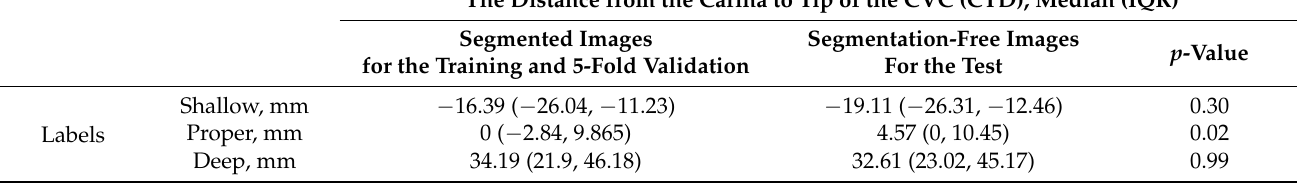
Table 1. Label-based comparison of the distances between the carina of the trachea and the tip of the CVC in segmented and segmentation-free image datasets. The Distance from the Carina to Tip of the CVC (CTD), Median (IQR)